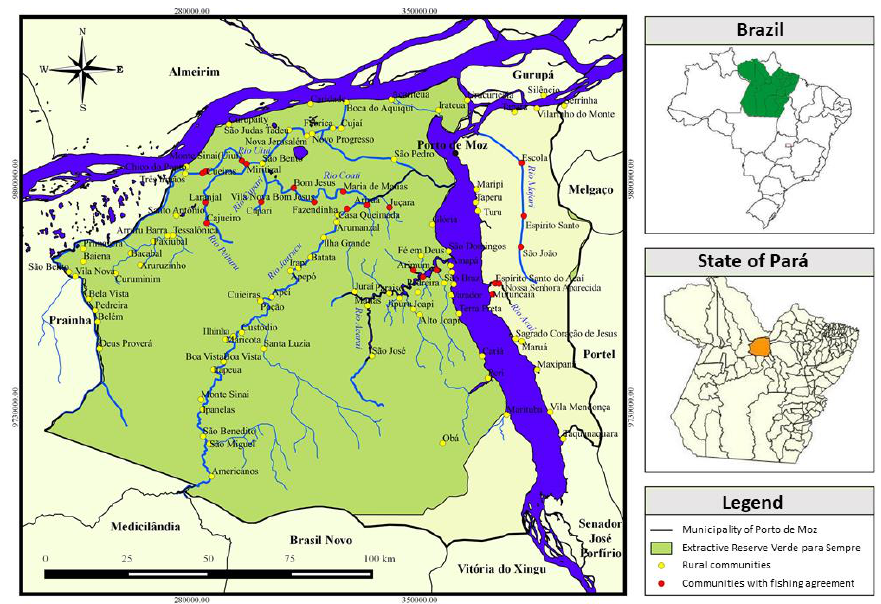
Figure 5. Communities with fishing agreements in the municipality of Porto de Moz. Source: Field- work.